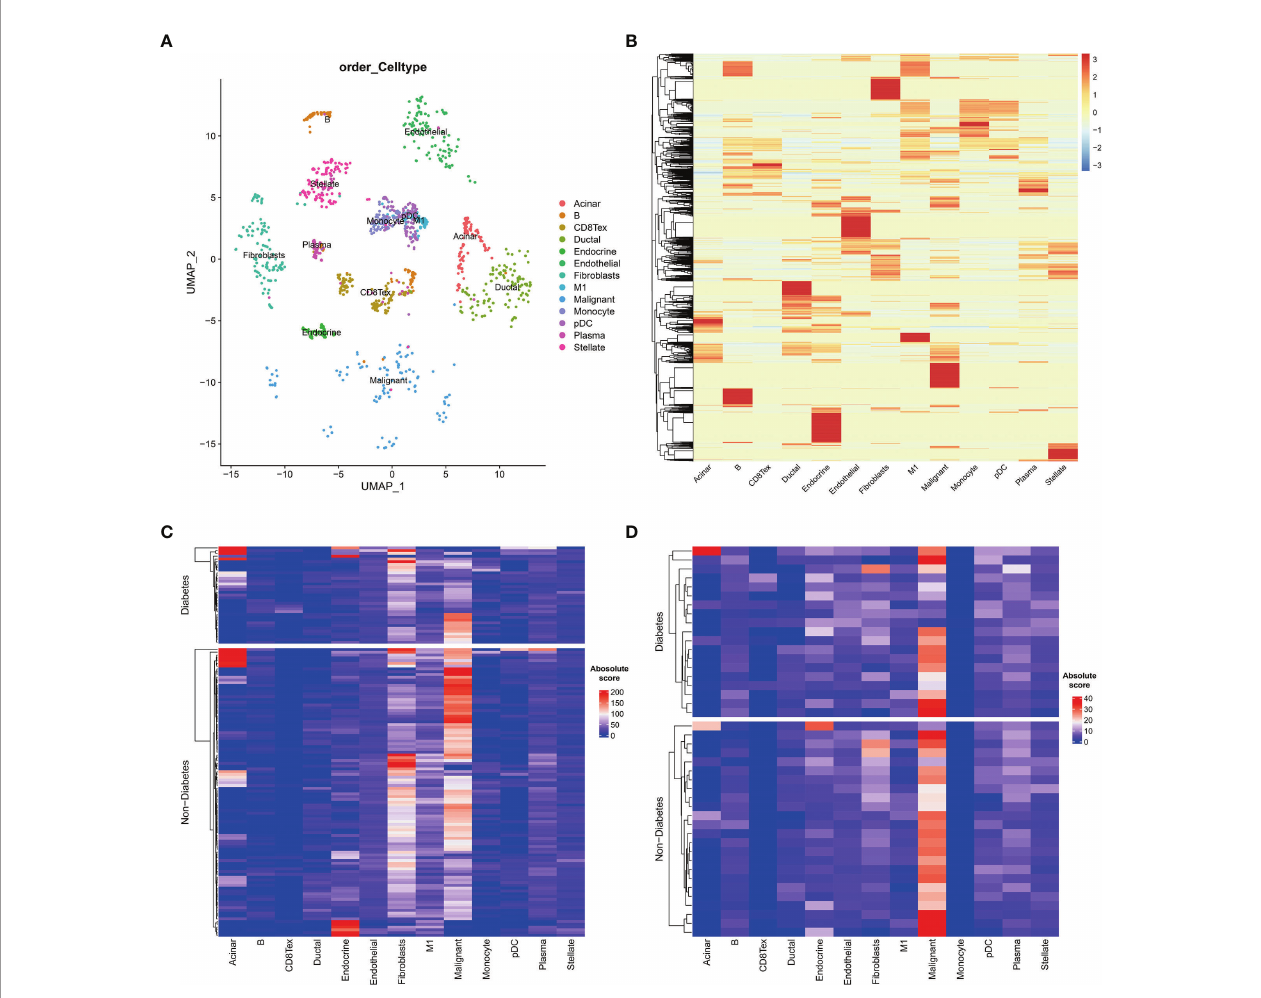
FIGURE 3 | Cell type expression pro fi le signature matrix. From the 13 clustered cell populations of the PAAD scRNAseq dataset, 100 cells of each cell type were randomly screened and the expression pro fi le feature matrix of these cell types was obtained by the CIBERSORTX algorithm. (A) Two-dimensional scatter clustering plot of umap for the 13 cell types obtained by PAAD scRNAseq. (B) Feature matrices obtained by the CIBERSORTX algorithm. (C) Absolute score clustering heat map of the 13 cells from the TCGA PAAD dataset. (D) Absolute score clustering heat map of 13 cells from the GSE79668